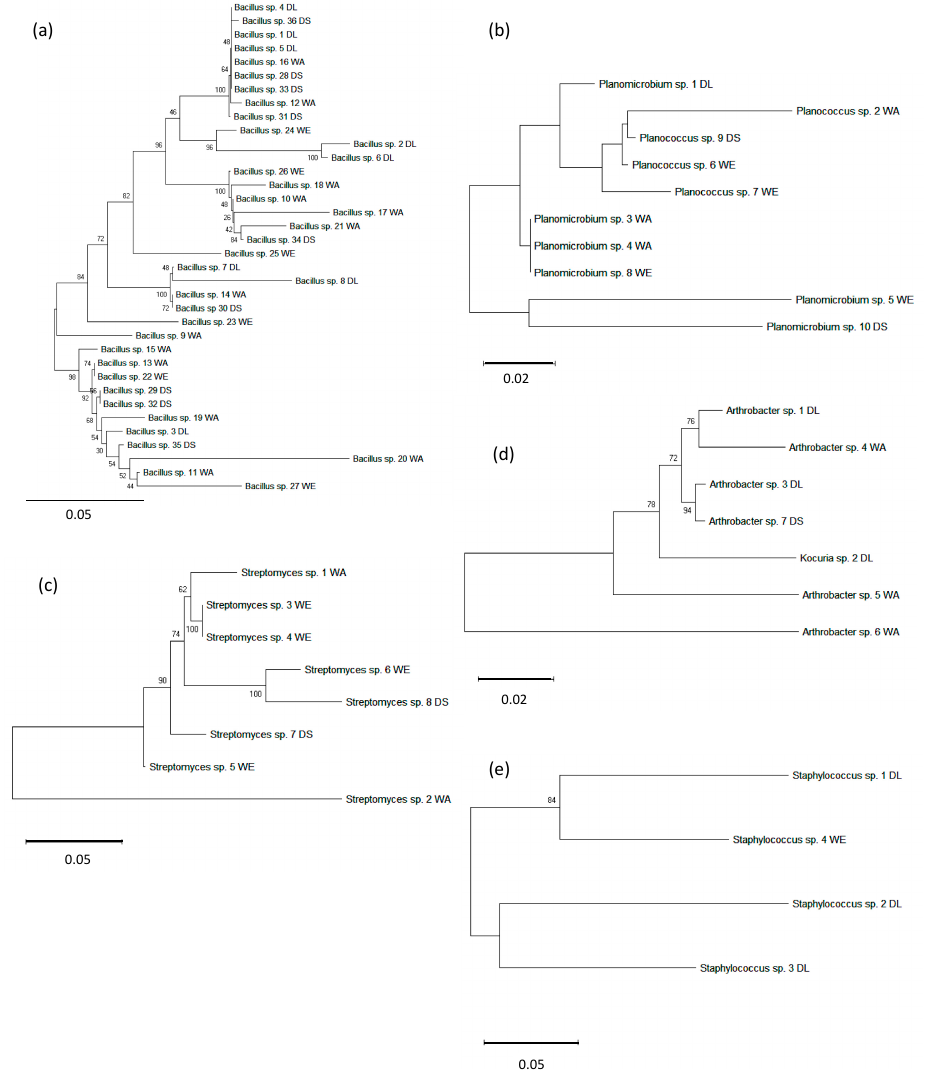
Figure 4. Phylogenetic tree analysis of 16s rDNA of five dominant strains bacteria identified in the study site. The number and symbol on the display indicate the isolation number of each bacterium and the abbreviation of the isolation site (dry lake bed: DL, desert step: DS, wadi: WA, well: WE). ( a ) The phylogenetic tree analysis of 16 s rDNA at each isolation site is shown for Bacillaceae , which is the dominant strain in DS and DL among the surveyed sites. ( b ) A phylogenetic analysis of 16s rDNA is shown for Planococcaceae , which is the dominant strain in WA. ( c ) The phylogenetic tree analysis of 16s rDNA is shown for Streptomycetaceae , which was relatively frequently identified in WE. ( d ) The phylogenetic tree analysis of 16s rDNA is shown for Micrococcaceae , mainly identified in DL and WA. ( e ) The phylogenetic analysis of 16s rDNA is shown for Staphylococcaceae , identified in WE and DL. The scale bar indicates the di ff erence in the number of compared bases after multiple alignment (substitution per nucleotide